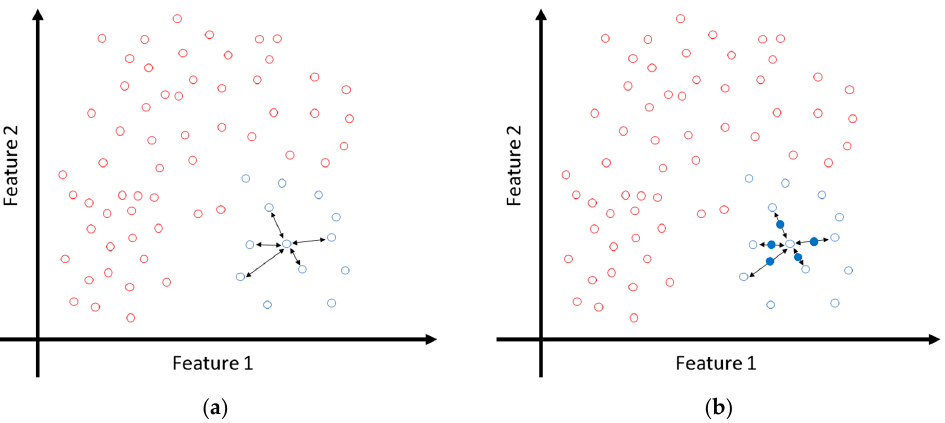
Figure 2. ( a ) SMOTE algorithm random selection process; ( b ) SMOTE algorithm random generation process.